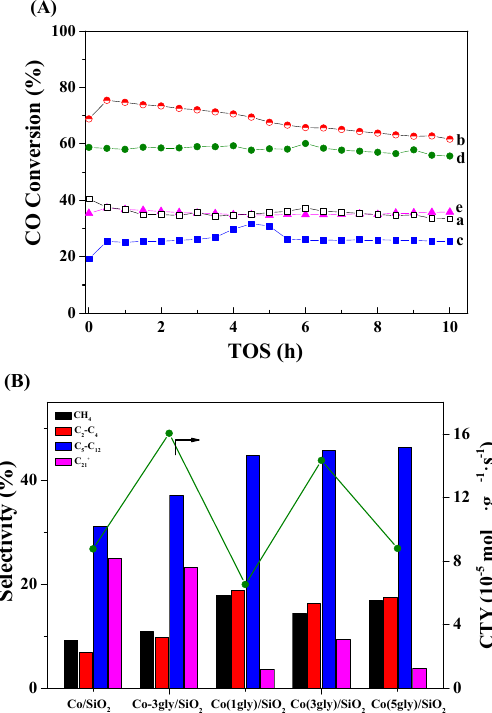
Figure 7. Time-on-stream CO conversion ( A ) and product selectivity ( B ) over Co/SiO 2 (a), Co- / SiO / SiO 3gly/SiO 2 (b), Co(1gly)/SiO 2 (c), Co(3gly)/SiO 2 (d), and Co(5gly)/SiO 2 (e). (b), Co(1gly) 2 (c), Co(3gly) 2 (d), and Co(5gly)